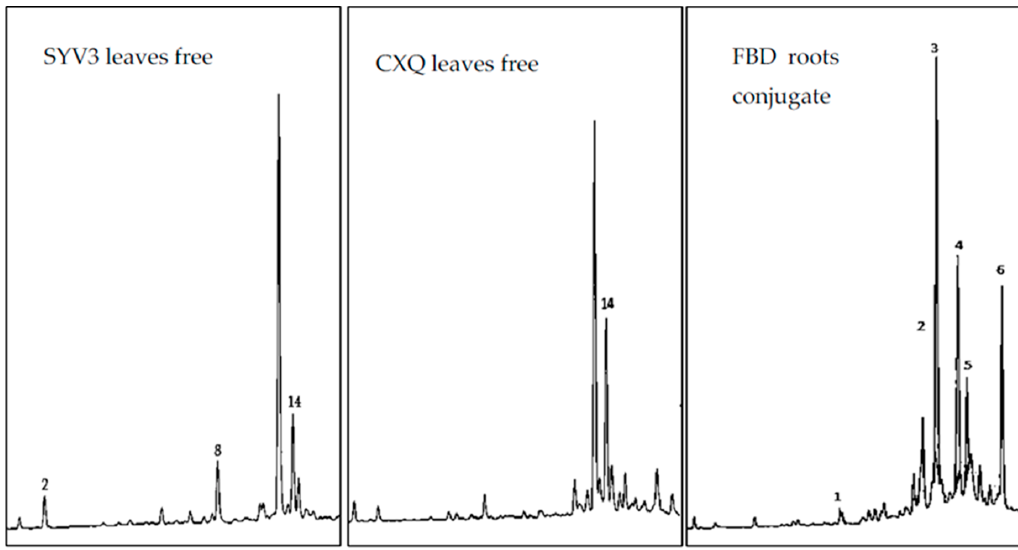
Figure 4. HPLC fingerprints of some samples (at 254 nm).